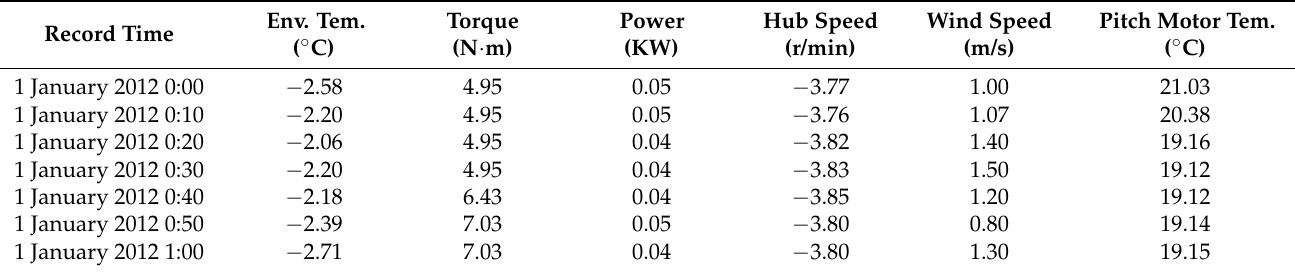
Table 1. Some attribute parameters of SCADA data from the No. 1 wind turbine in a wind